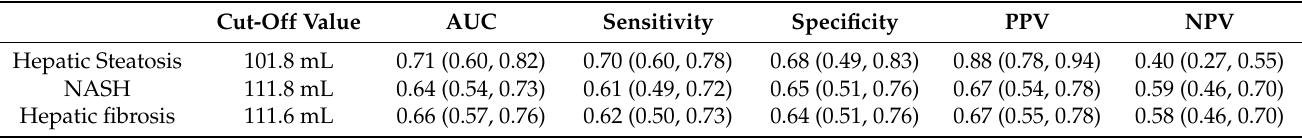
Table 3. Diagnostic accuracy of VAT for estimation of hepatic steatosis, NASH and hepatic fibrosis in the study cohort *. Cut-Off Value